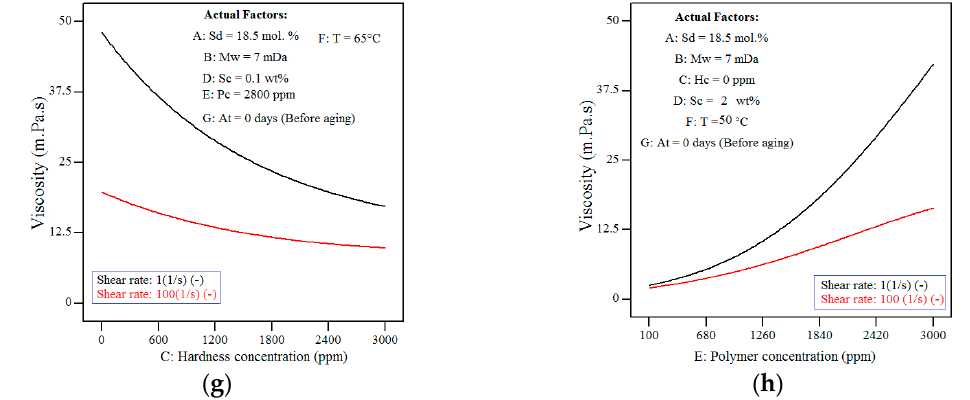
Figure 9. Interaction plot between model inputs, ( a ) polymer concentration and sulfonation degree, ( b ) salinity concentration and molecular weight, ( c ) polymer concentration and molecular weight, ( d ) shear rate and molecular weight, ( e ) salinity concentration and hardness concentration, ( f ) polymer concentration and salinity concentration, ( g ) shear rate and hardness concentration, ( h ) shear rate and polymer concentration.